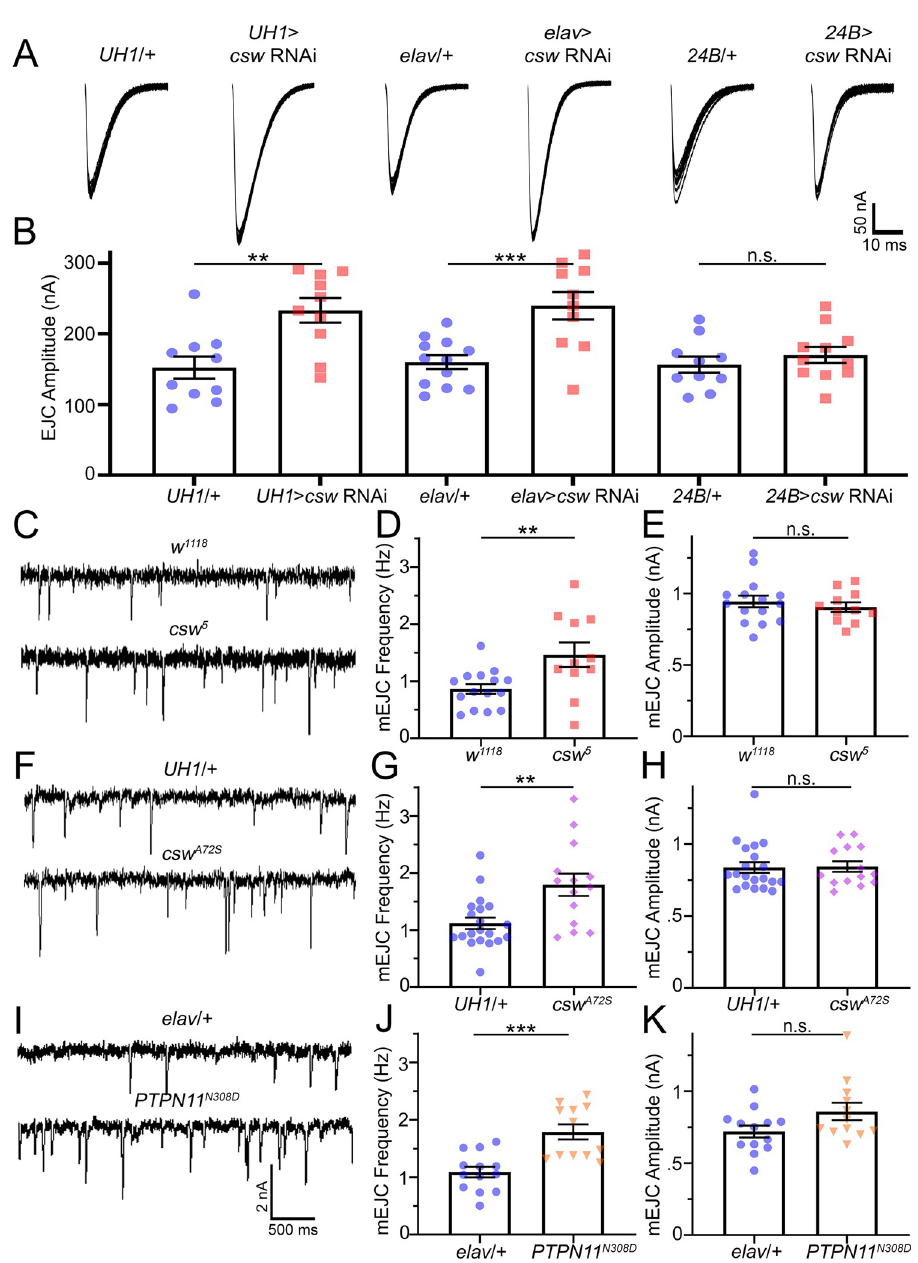
Fig 2. Targeted neuronal csw knockdown increases presynaptic neurotransmission. Nerve stimulation–evoked recordings based on csw RNAi expressed ubiquitously ( UH1 -Gal4) or targeted to neurons ( elav -Gal4), or muscles ( 24B -Gal4). ( A) Representative EJC traces showing 10 superimposed responses (1.0 mM Ca +2 ) from control ( UH1 - Gal4/TRiP) vs. csw RNAi; control ( elav -Gal4/TRiP) vs. csw RNAi; and control ( 24B -Gal4/TRiP) vs. csw RNAi. ( B) Quantification of EJC amplitudes using two-sided t tests. ( C) Representative mEJC traces (1.0 mM Ca 2+ ) in genetic background control ( w 1118 , top) and csw 5 null (bottom). ( D) Quantification of the mEJC frequencies using a two-sided t test. ( E) Quantification of the mEJC amplitudes using a two-sided t test. ( F) Sample mEJC recordings from the driver control ( UH1 -Gal4/ w 1118 ; top) compared to csw A72S GoF (UH1 -Gal4 > csw A72S ; bottom). (G) Quantification of the mEJC frequencies using a two-sided t test. ( H) Quantification of mEJC amplitudes using Mann–Whitney test. ( I) Sample mEJC recordings in control ( elav -Gal4/ w 1118 ; top) compared to PTPN11 N308D GoF ( elav -Gal4 > PTPN11 N308D ; bottom). (J) Quantification of the mEJC frequency using a Mann–Whitney test. ( K) Quantification of mEJC amplitude using a Mann–Whitney test. Scatter plots show all the data points and mean ± SEM. N = number of NMJs. Significance: p > 0.05 (not significant, n.s.), p < 0.05 ( � ), p < 0.001 ( �� ), and p < 0.0001 ( ��� ). The data underlying this figure can be found in S1 Data. csw , corkscrew; EJC, excitatory junction current; mEJC, miniature EJC; NMJ, neuromuscular junction; RNAi, RNA interference.